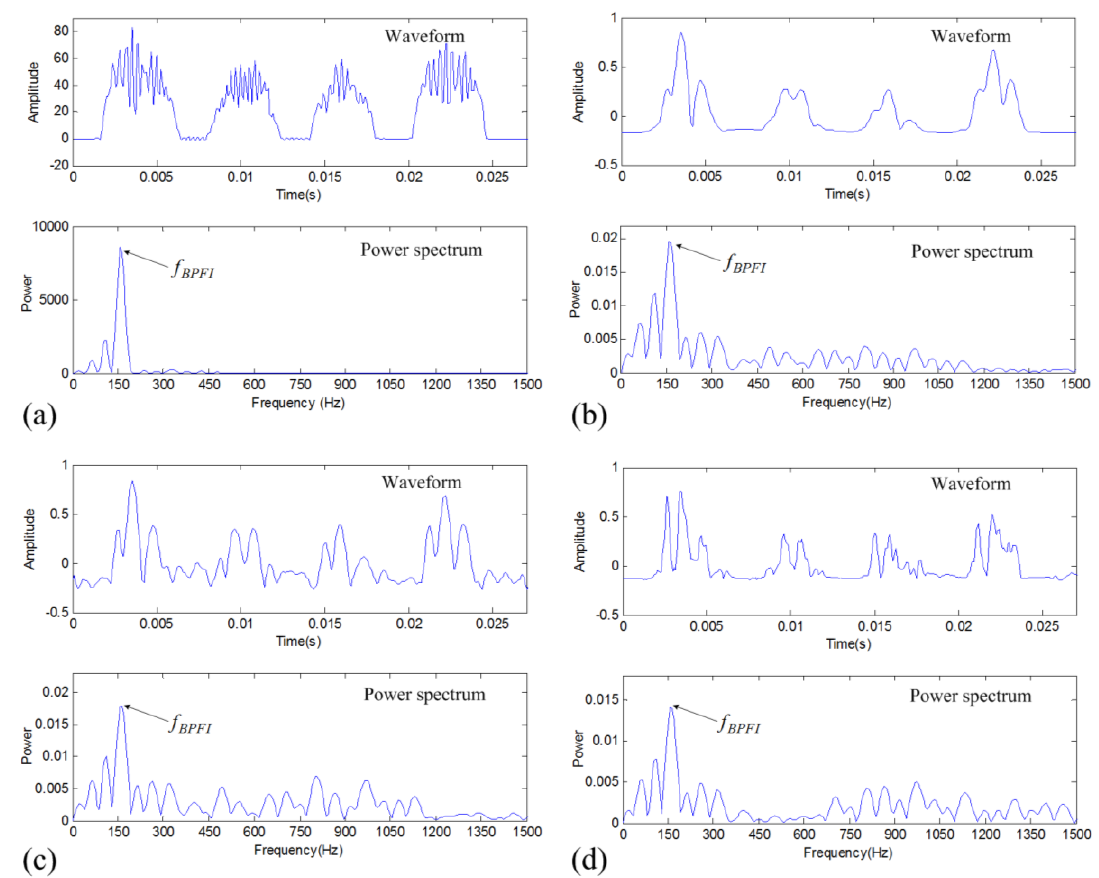
Figure 10. Fault diagnosis results of the inner-race defective vibration signal: ( a ) FPTS spectrum of TFM-based denoised signal; ( b ) envelope spectrum of TFM-based denoised signal; ( c ) envelope spectrum of band-pass filtered signal; and ( d ) envelope spectrum of DWT-based denoised